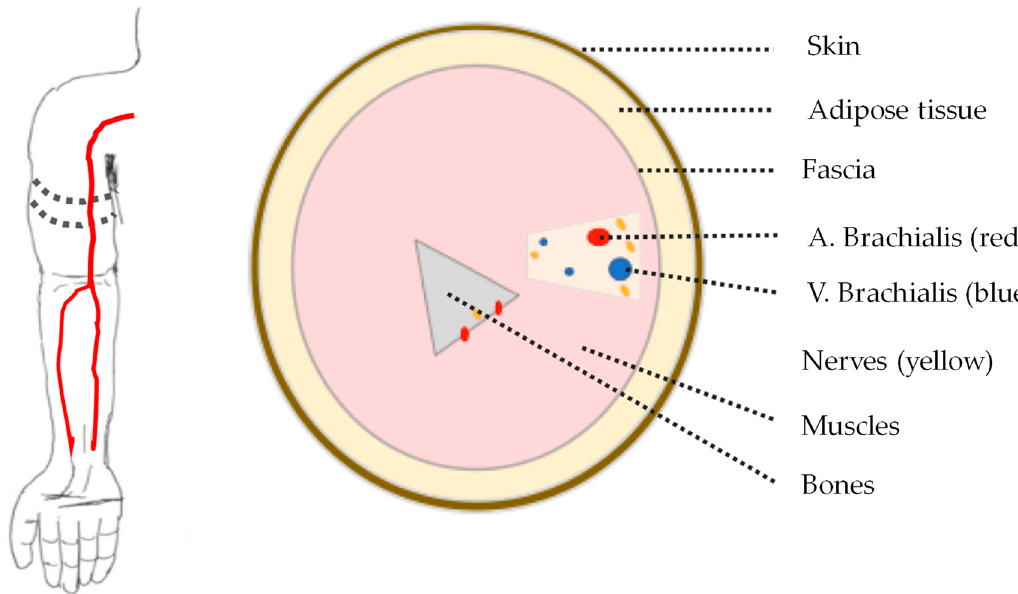
Figure 1. Illustration of a human arm with brachial artery ( left ) and schematic cross-section of upper arm ( right ). Anatomically, the upper arm consists mainly of muscle tissue; humerus bone; fat tissue; skin tissue; and arterial, venous, lymphatic, and nerve plexus. The brachial artery runs along the inside of the upper arm and represents the artery typically used for blood pressure measurement with an upper arm cuff. It has an average inner vessel wall diameter of about 5 mm, which expands by up to 0.5 mm due to the pulsatile blood flow. A setup of a sensor consisting of a transmitter and receiver pair with electromagnetic signals in the gigahertz range measure path length differences as echoes between the sensor and objects. Applied to a human body, the thorax movement of up to several millimeters are measured, which are caused by breathing or by heartbeat on the body surface, as shown in [4,5]. With the approach, non-invasive bio-parameters of individuals, such as respiratory rate and heart rate, can also be captured, as shown in [6,7]. The